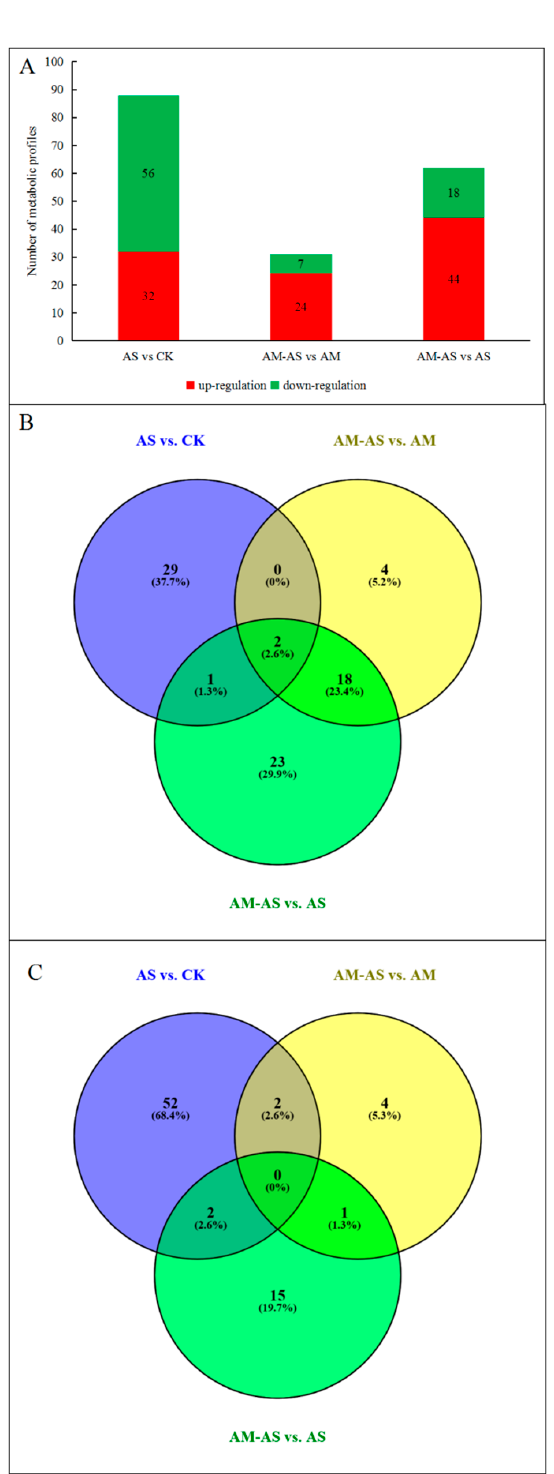
Figure 4. Identification and statistics of metabolic changes under alkali stress. ( A ) Number of up-or down-accumulated metabolic profiles between AM seedlings and non-AM seedlings of P. tenuiflora under alkali stress. ( B ) Venn diagram analysis of up-accumulated metabolic profiles in non-AM seedlings and AM seedlings under alkali stress. ( C ) Venn diagram analysis of down-accumulated metabolic profiles in non-AM seedlings and AM seedlings under alkali stress. CK: control treatment, AS: alkali stress without arbuscular mycorrhizal, AM: arbuscular mycorrhizal treatment, AM-AS: alkali stress with arbuscular mycorrhizal.